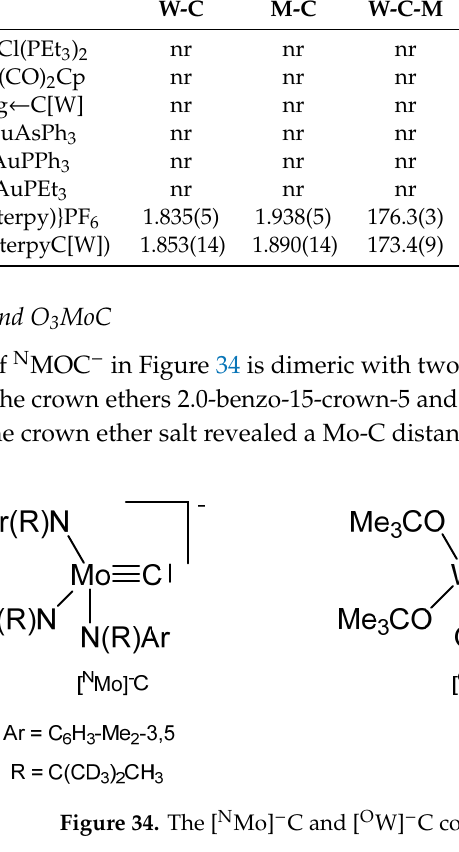
Figure 33. Structural representation of [W]C → Pt complexes [125]. Table 17. Compounds with [W] − C core. Tp* = [HB(pzMe 2 ) 3 ] − .